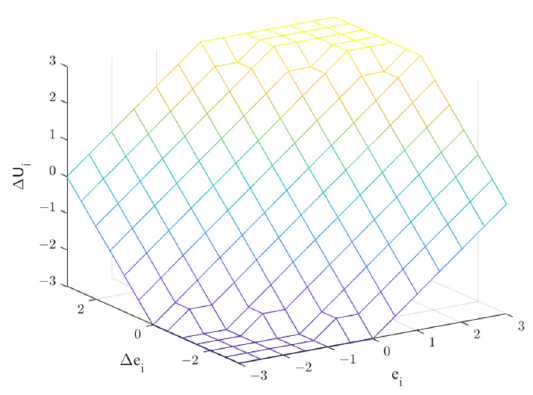
Figure 4. Real output surface ∆ U of the fuzzy PI controller as a function of the real inputs ( e , ∆ e ).